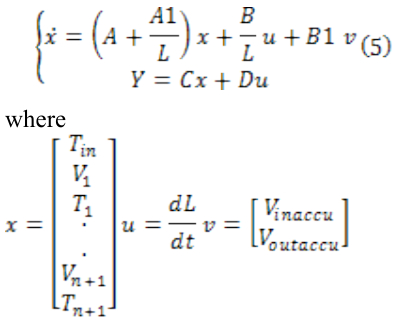
Web velocity calculation: